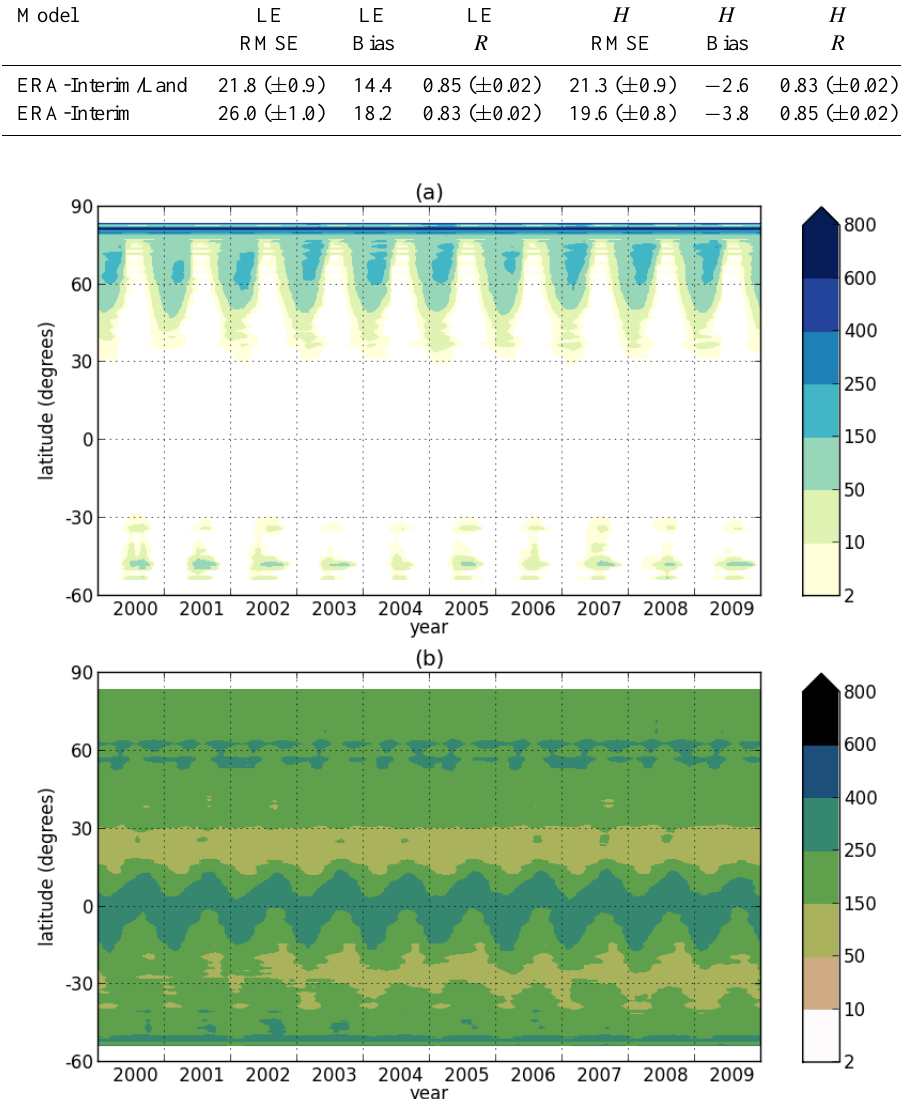
Figure 4. ERA-Interim Hovmöller diagram of the land water reservoirs (zonally averaged over land) for the 2001–2010 period: (a) SWE (kgm − 2 ) and (b) TCSM (kgm − 2